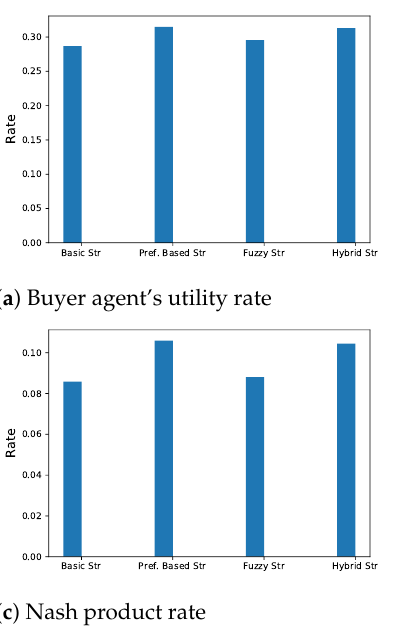
Figure 11. Utility and Nash product per agreement rates with medium overlap and random deadlines.